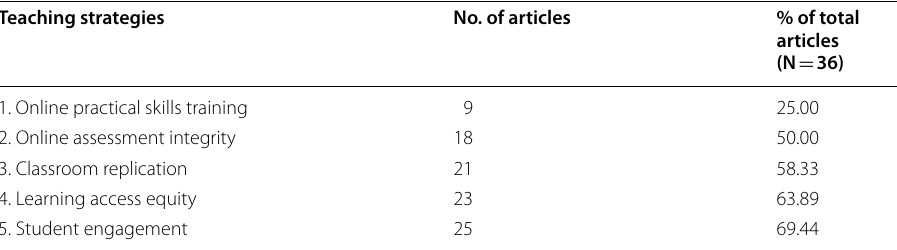
Table 3 Teaching strategies Teaching